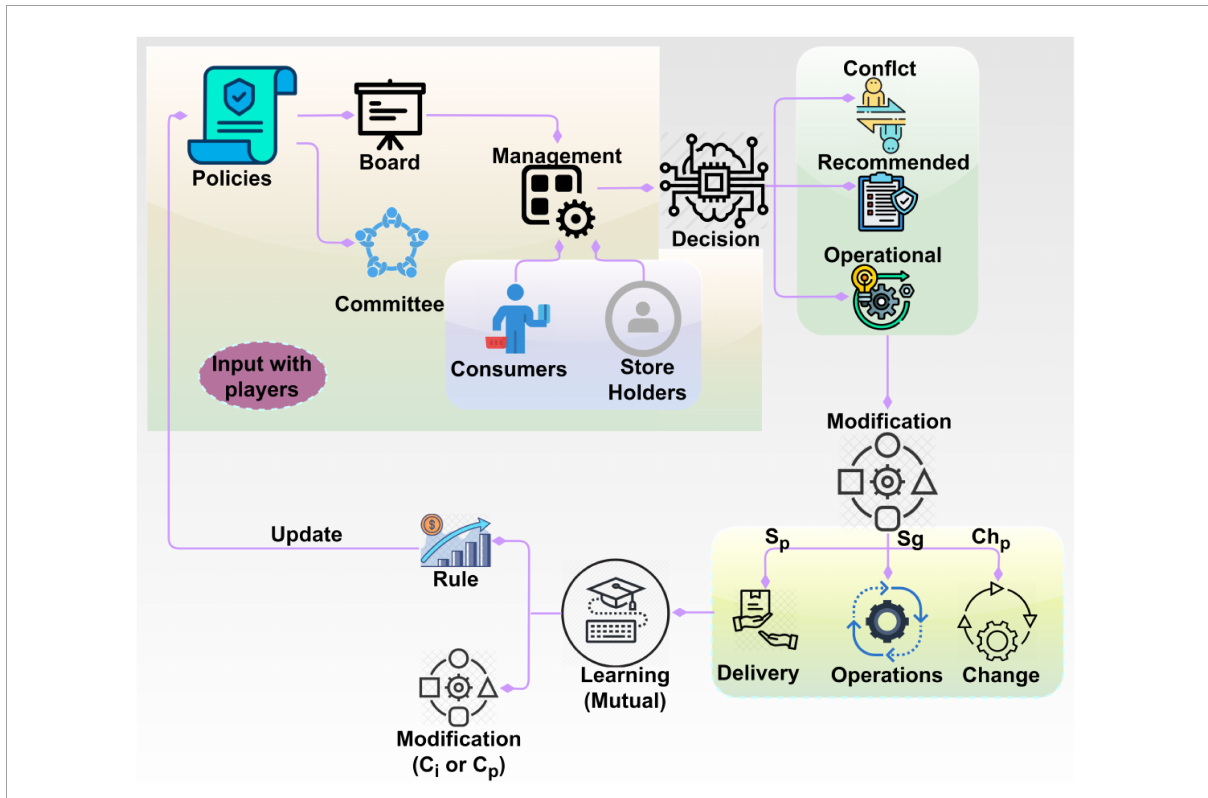
FIGURE3 Policy management using transfer